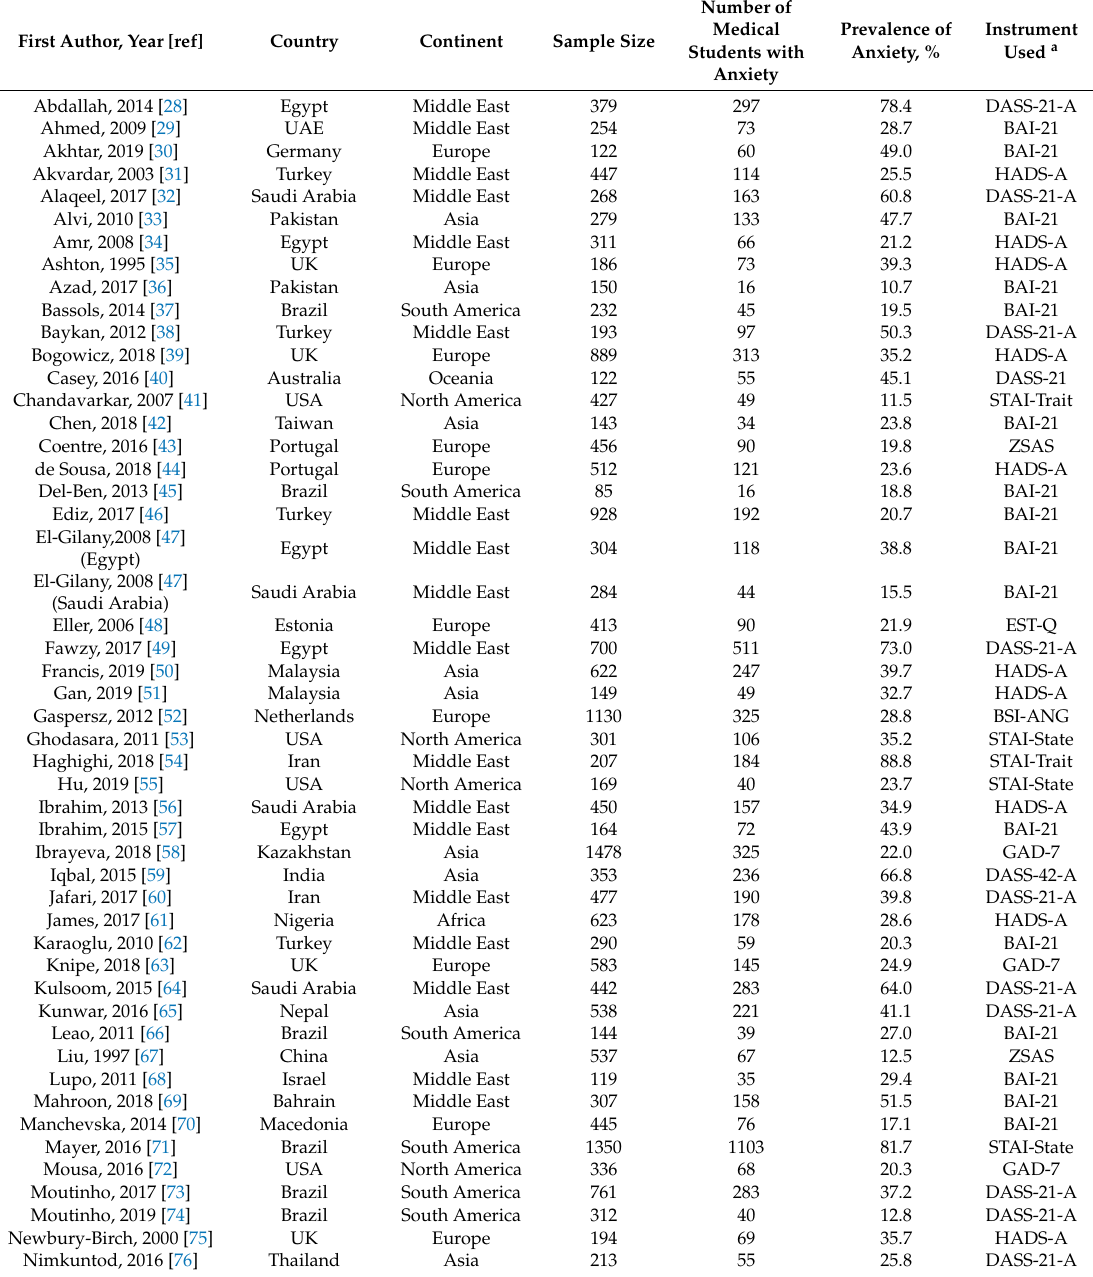
Table 1. Location, prevalence rate of anxiety and instrument used to assess anxiety in sixty-nine studies examining anxiety in medical